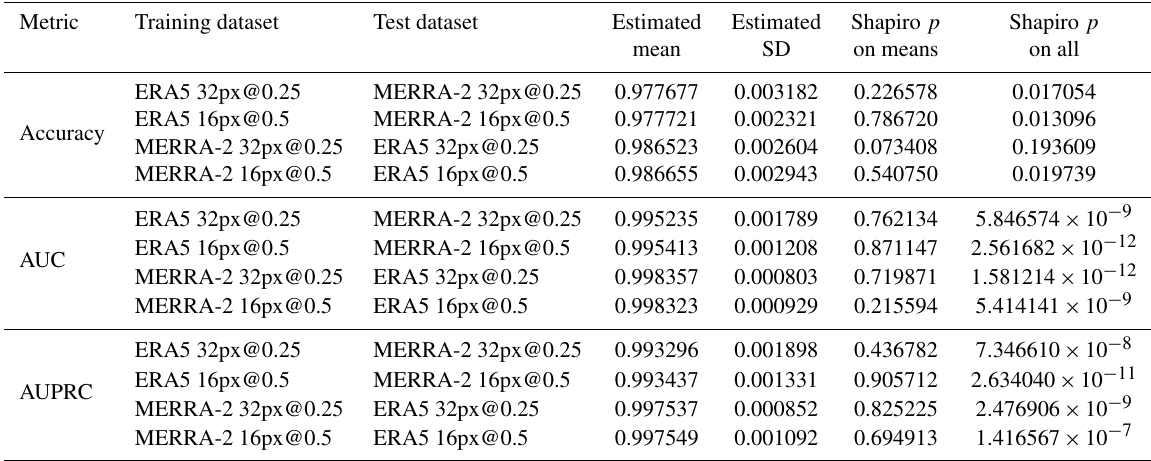
Table A4. The estimation of the values of the metrics based on iterative cross-validation. The training and test datasets come from different image set but have the same image resolution and size (cross-comparisons). The column “Shapiro p on means” refers to the p value of the Shapiro–Wilk test computed on the mean of each iteration, whereas “Shapiro p on all” refers to the p value computed on all the values of the